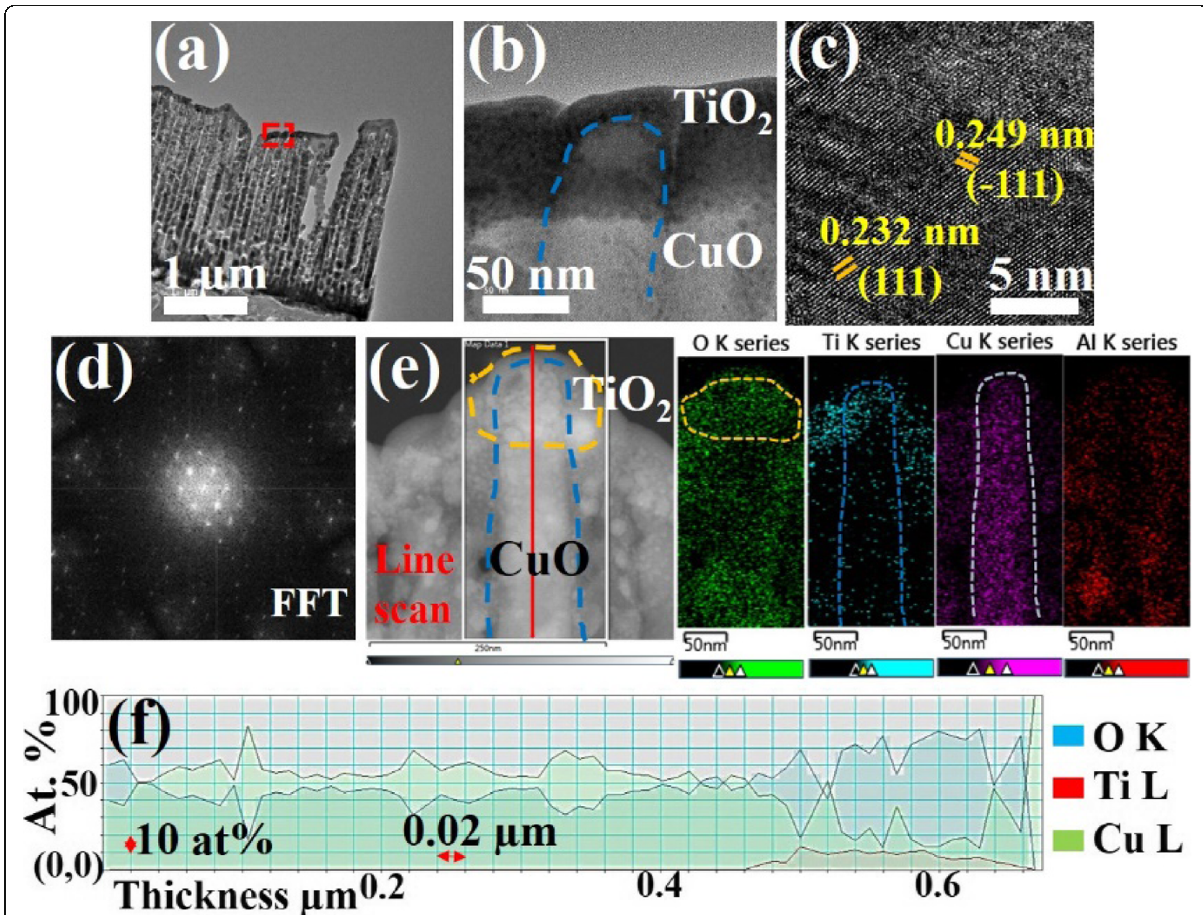
Fig. 4 a A low-magnification TEM image of CuO NRs array capped by a TiO 2 thin layer. b The corresponding HRTEM image of the TiO 2 -capped CuO NR taken from the rectangular area indicated in a . c d-spacing and d FFT results of CuO NRs. e EDS mapping images and f EELS line scan results of CuO/TiO